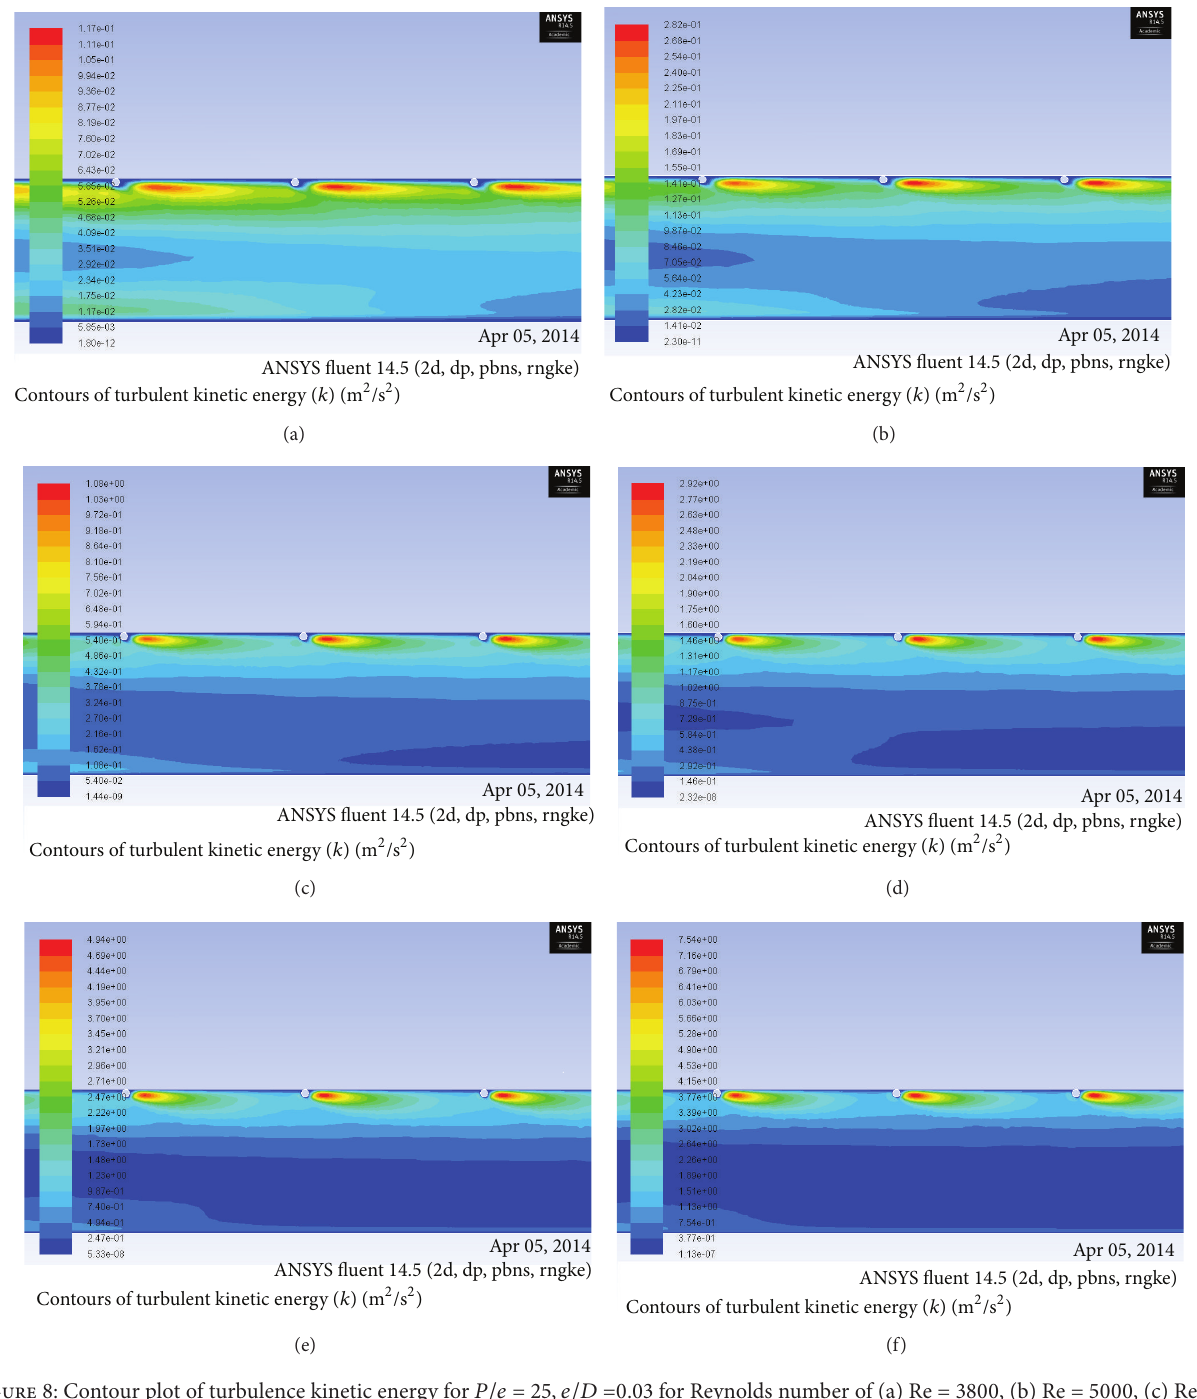
Figure 8: Contour plot of turbulence kinetic energy for 𝑃/𝑒 = 25, 𝑒/𝐷 =0.03 for Reynolds number of (a) Re = 3800, (b) Re = 5000, (c) Re = 8000, (d) Re = 12000, (e) Re =15000, and (f) Re =